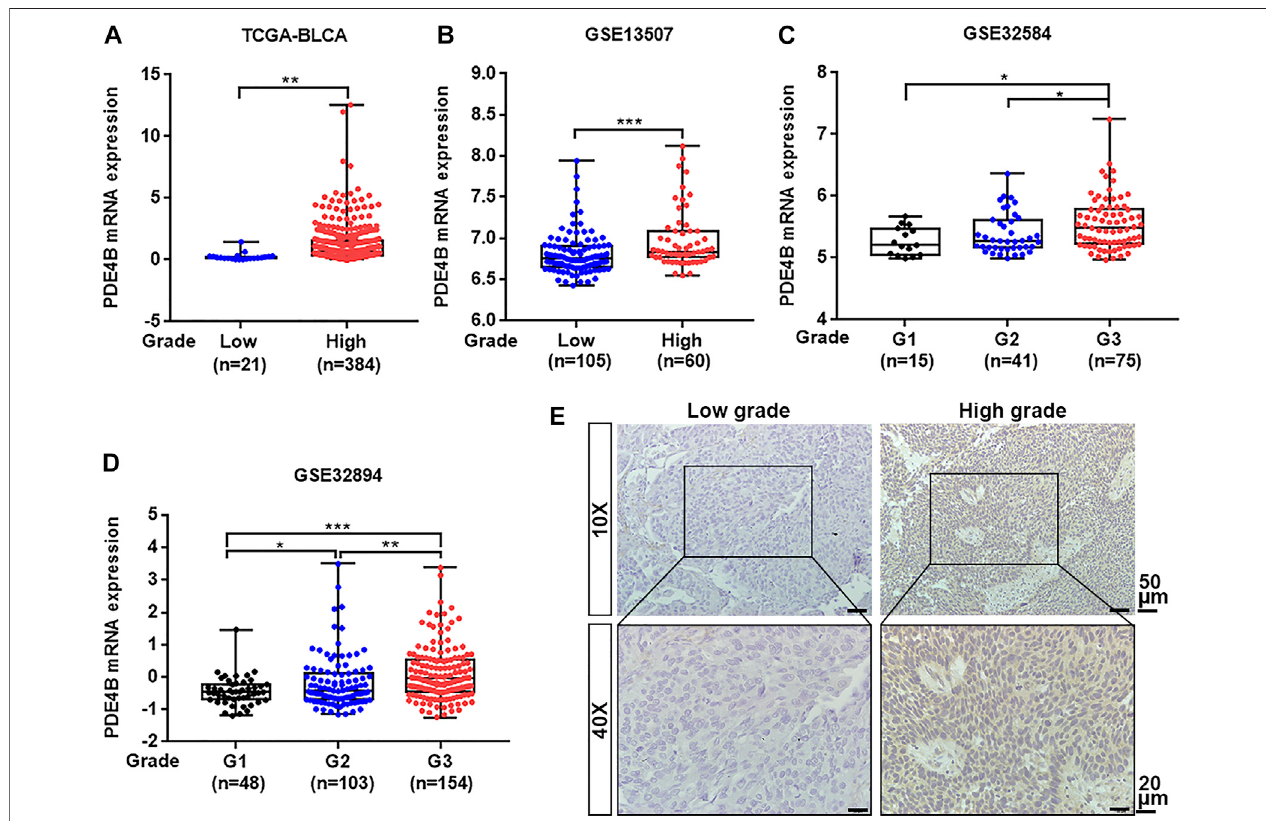
TABLE 1 | The association between PDE4B protein levels and clinicopathological features of UBC patients ( n (cid:2) 59). Characteristics